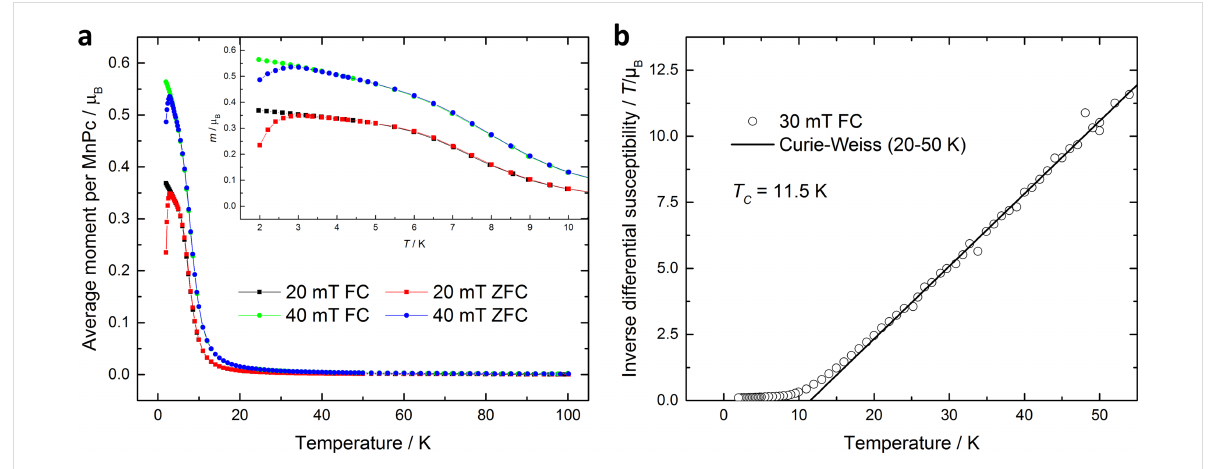
Figure 5: (a) Magnetisation as a function of the temperature at fields of 20 mT and 40 mT using both FC and ZFC protocols. (b) Inverse differential susceptibility calculated from the magnetisation measurements showing a Curie temperature of 11.5 K.